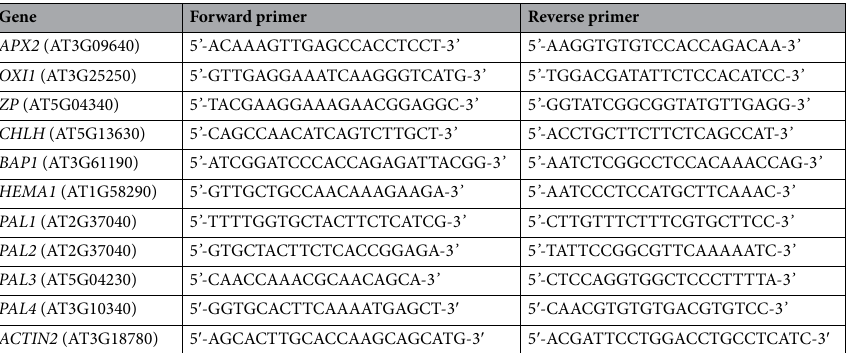
Table 1. Primers of genes tested by real-time quantitative